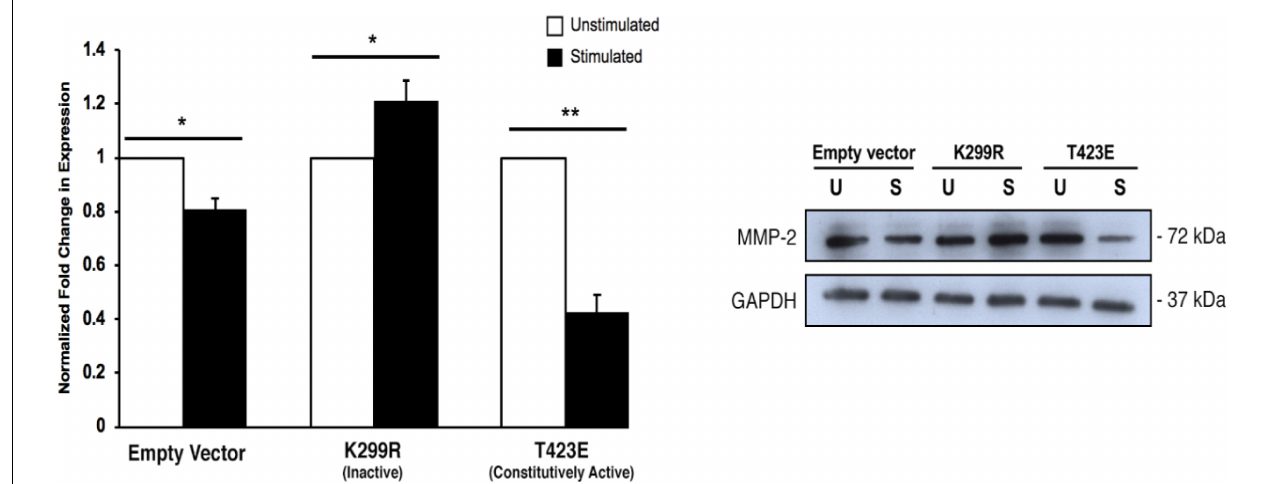
FIGURE 5 | Intracellular MMP-2 expression increases with when the PAK1 kinase-dead mutant is overexpressed. When PAK1 is inactive (K299R), there is a significant increase in intracellular MMP-2 expression with stimulation. When PAK1 is constitutively active (T423E), there is a decrease in MMP-2 expression with